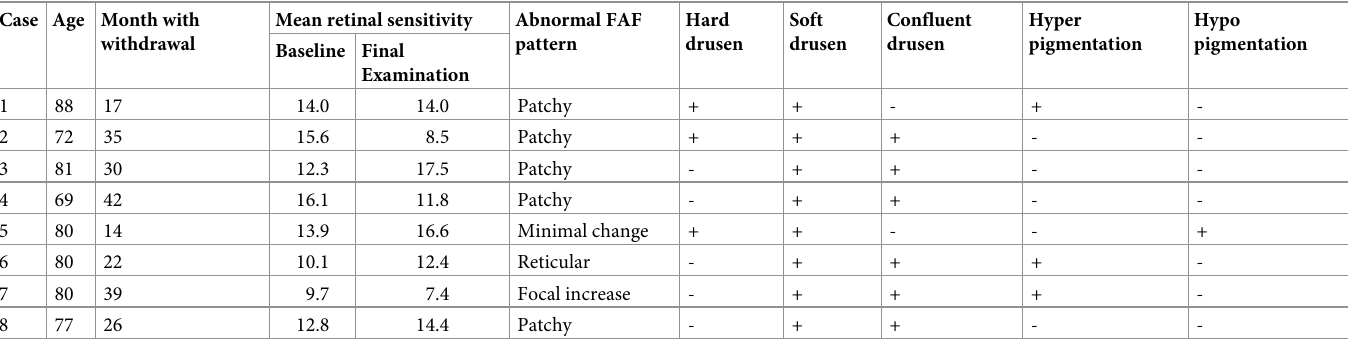
Table 1. Characteristics of eight eyes with progression to exudative AMD. Case Age Month with